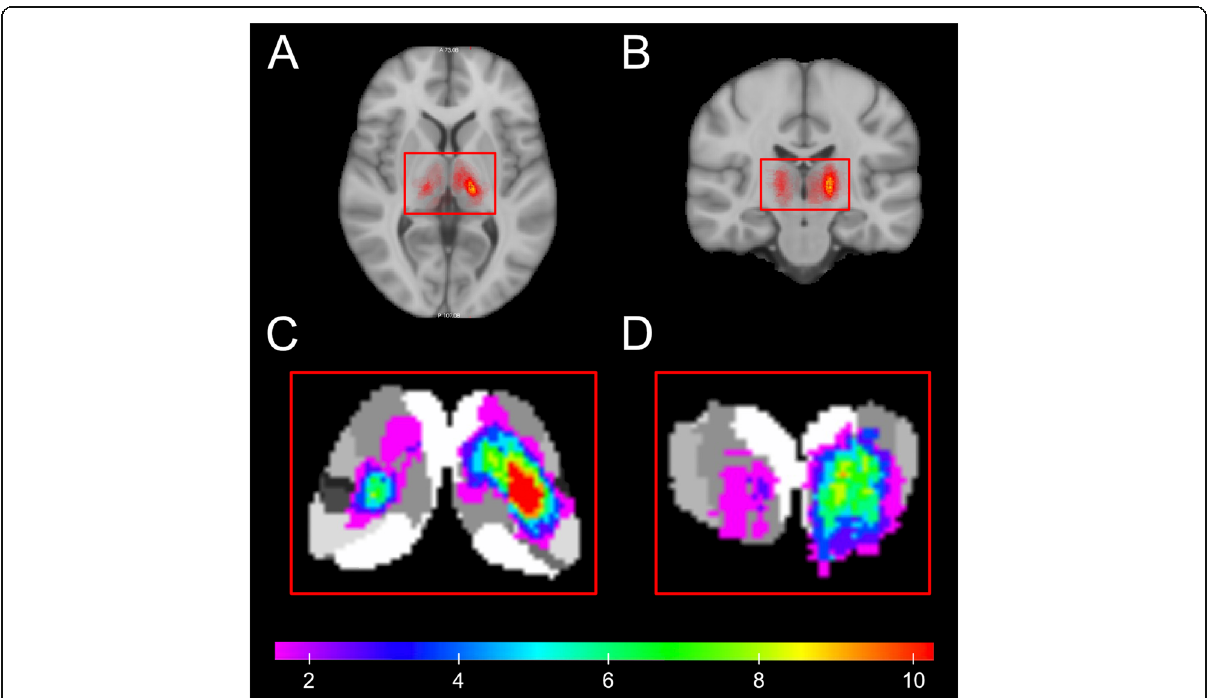
Fig. 3 Lesion-overlap maps in axial and coronal plane of 52 thalamic stroke lesions. Upper row images illustrate the distribution patterns of thalamic strokes in axial (A) and coronal (B) slice in T1-weighted MNI standard space. A higher frequency of infarct lesions in the left thalamus is clearly visible. Lower row images provide a magnified lesion-overlap map of the thalamus in axial (C) and coronal (D) orientation, projected on seven sub-thalamic segments in standard space of the Oxford thalamic connectivity atlas [20]. The lesion distribution pattern as indicated by color visualizes the predominance of left anterior thalamic lesions in the anteromedian and anterolateral vascular territories when compared to right anterior thalamic